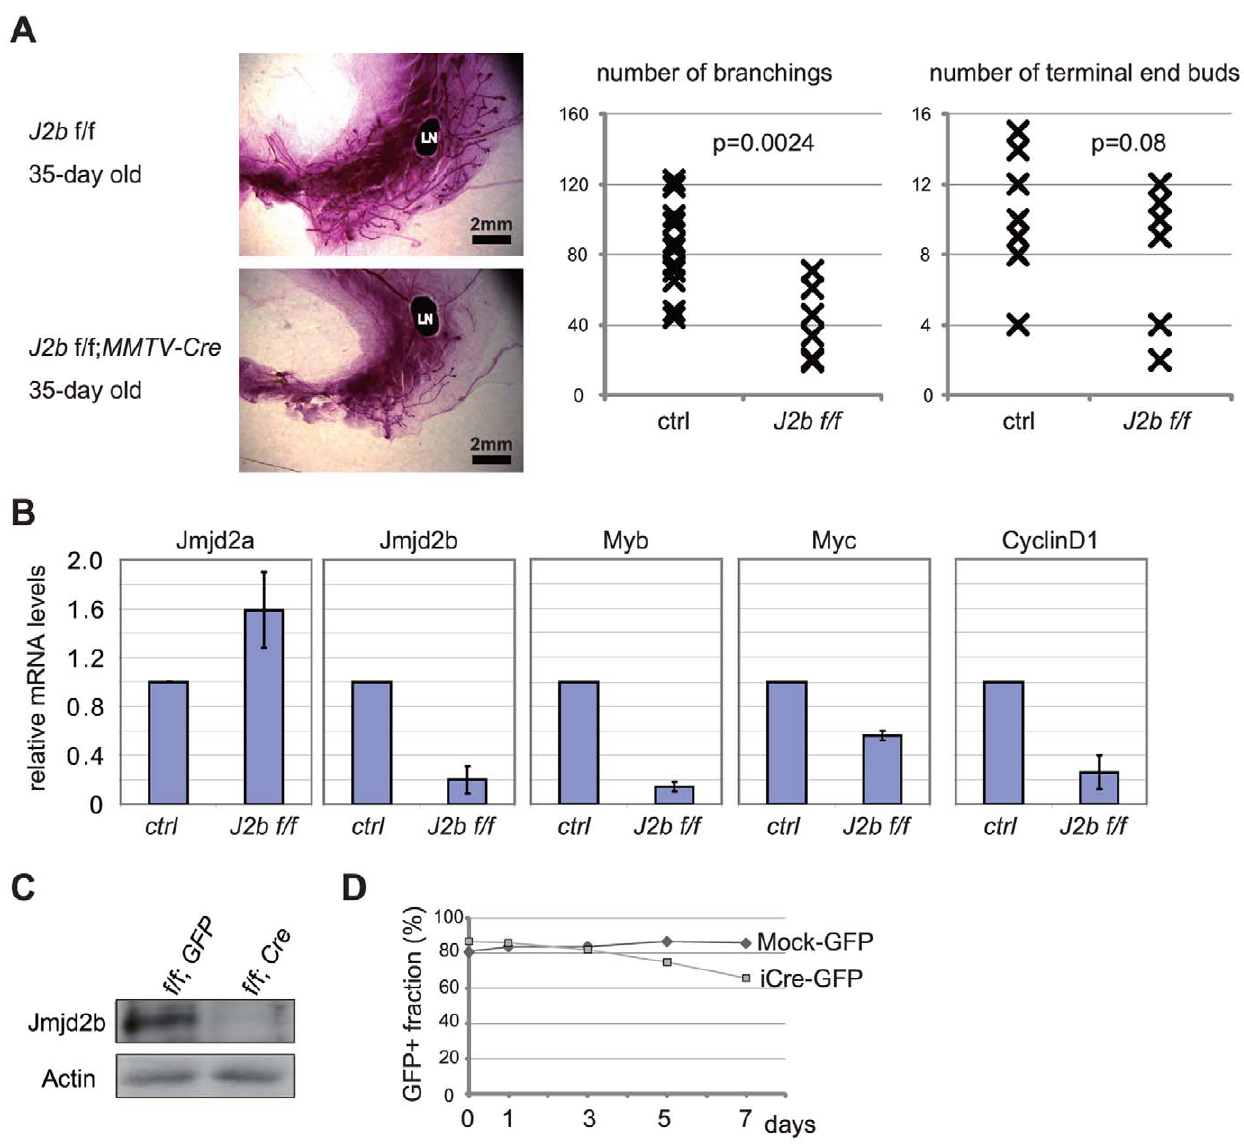
Figure 6. Conditional deletion of Jmjd2b in mammary epithelium results in defective mammary gland development. (A) Defective development of Jmjd2b -deficient mammary gland. Carmine-stained whole-mount preparations of mammary glands from 5-week old Jmjd2b flox/flox ; MMTV-Cre and Jmjd2b flox/flox mice (Ctrl:control). Representative littermates are shown. LN, lymph node. The numbers of branching and terminal end buds within a fat pad were determined ( Jmjd2b flox/flox n=11; MMTV-Cre ; Jmjd2b flox/flox : n=6). (B) Impaired gene expression in Jmjd2b flox/flox ; MMTV-Cre MECs. Lin 2 MECs were isolated from Jmjd2b flox/flox ; MMTV-Cre and Jmjd2b flox/flox mice. mRNA levels of Jmjd2b , Myb , CyclinD1 and c-myc were examined by real-time RT-PCR. Results represent mRNA levels normalized to the level of Actb mRNA (mean 6 s.d. of five independent littermate pairs). (C) Western blot showing the absence of Jmjd2b protein in Cre-infected Jmjd2b flox/flox MECs. Full-length blots are in Figure S7 (D) Impaired proliferation of Jmjd2b -deficient MECs. Lin 2 MECs were isolated from Jmjd2b flox/flox mice, infected with Mock- GFP or Cre-IRES-GFP (iCre-GFP) retrovirus, and cultured in vitro . Fractions of GFP-positive cells were determined at the indicated time points by FACS analysis. A representative result from three independent experiments is